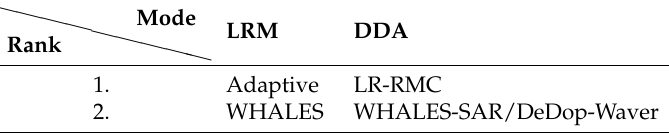
Table 6. Selection of the SeaState_cci project management and production